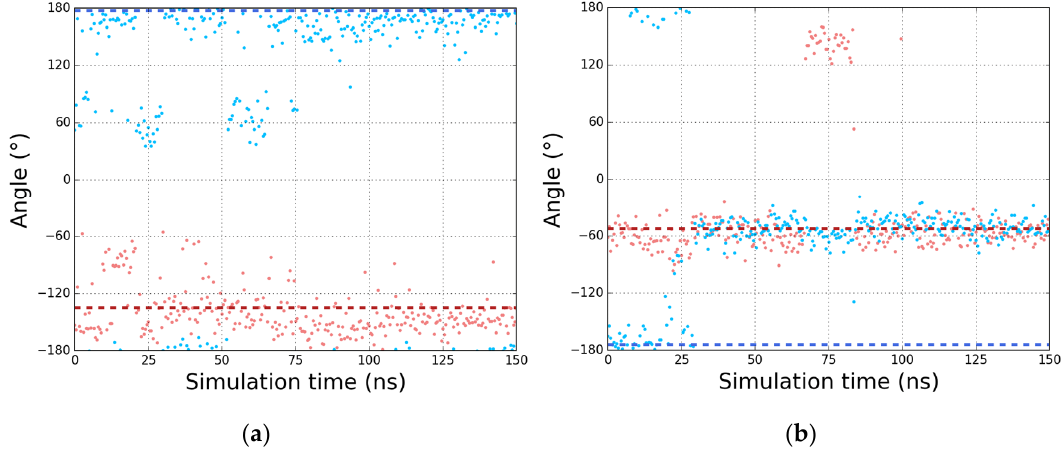
Figure 5. Values of dihedral angles τ 1 (orange dots) and τ 2 (cyan dots) (defined in Figure 3) monitored during 150 ns MD simulation for ( S )- 10 ( a ) and ( R )- 10 ( b ) in complex with the MT 2 receptor. Dashed lines represent the dihedral values τ 1 (red) and τ 2 (blue) assumed in the minimized docked poses.